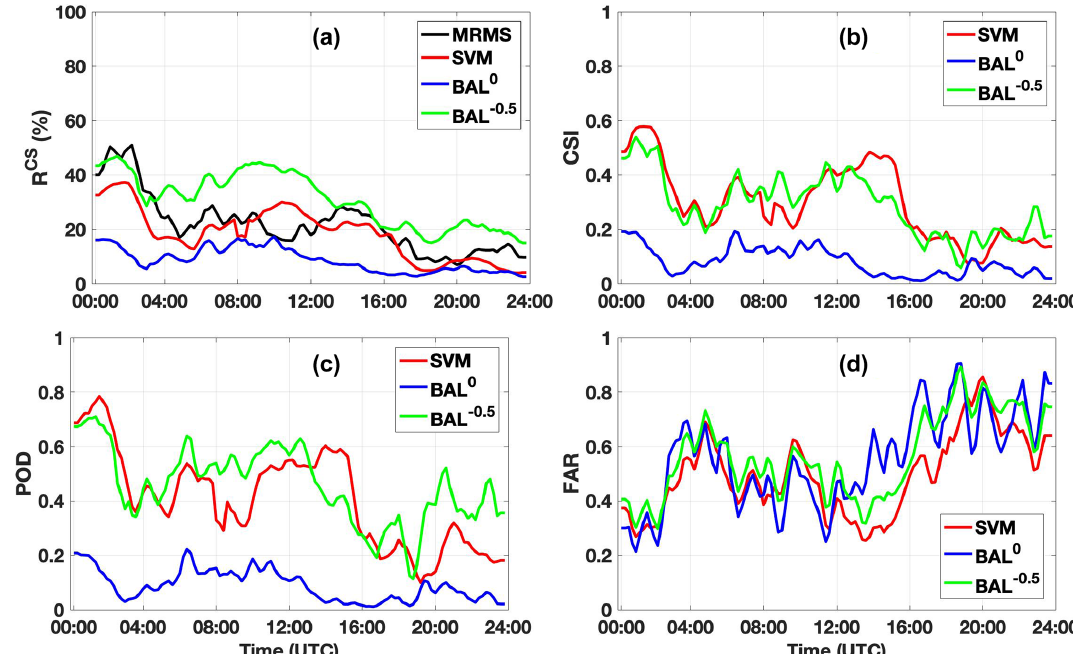
Figure 4. The time series plot of R CS (a) , CSI (b) , POD (c) , and FAR (d) from 30 August 2011. 24h data (00:00–2400UTC) are used in each case. The results from BAL with the threshold T 0 = − 0 . 5, BAL with the threshold T 0 = 0, SVM, and MRMS are presented by green, blue, red, and black lines,